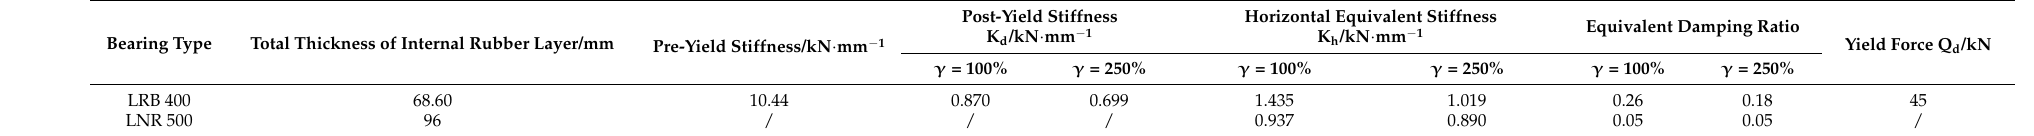
Table 1. Specifications and mechanical characteristics of isolation